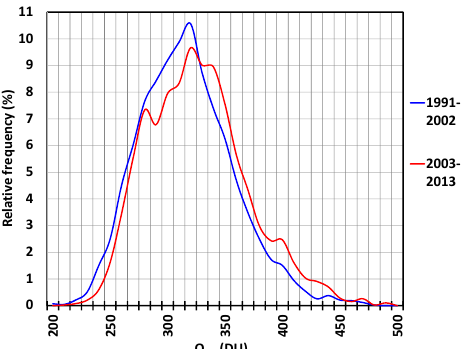
Figure 4. Relative frequency distribution of daily aerosol optical Fig. 4. Relative frequency distribution of daily Aerosol Optical Depth values for the two time depth values for the two time periods: 1991–2002 (in blue) and periods: 1991-2002 (in blue) and 2003-2013 (in red). 2003–2013 (in